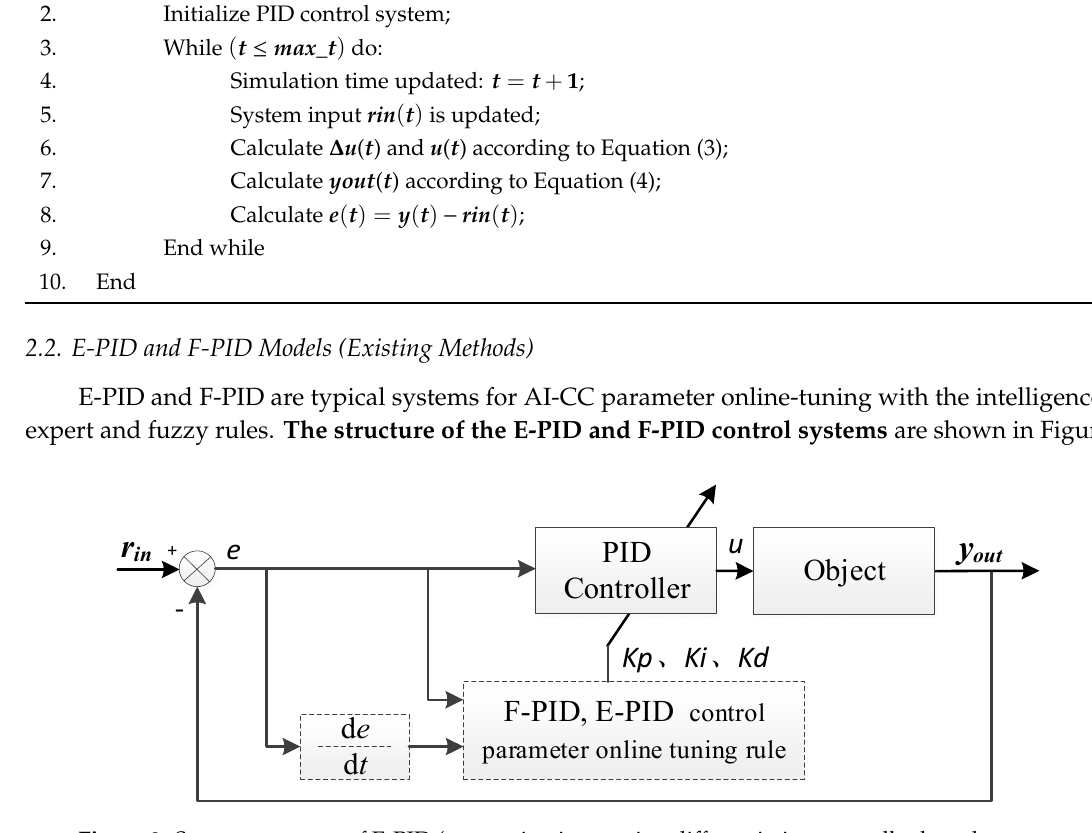
Algorithm 1 PID ( proportion integration differentiation ) control method Algorithm 1 PID (proportion integration di ff erentiation) control method 1.